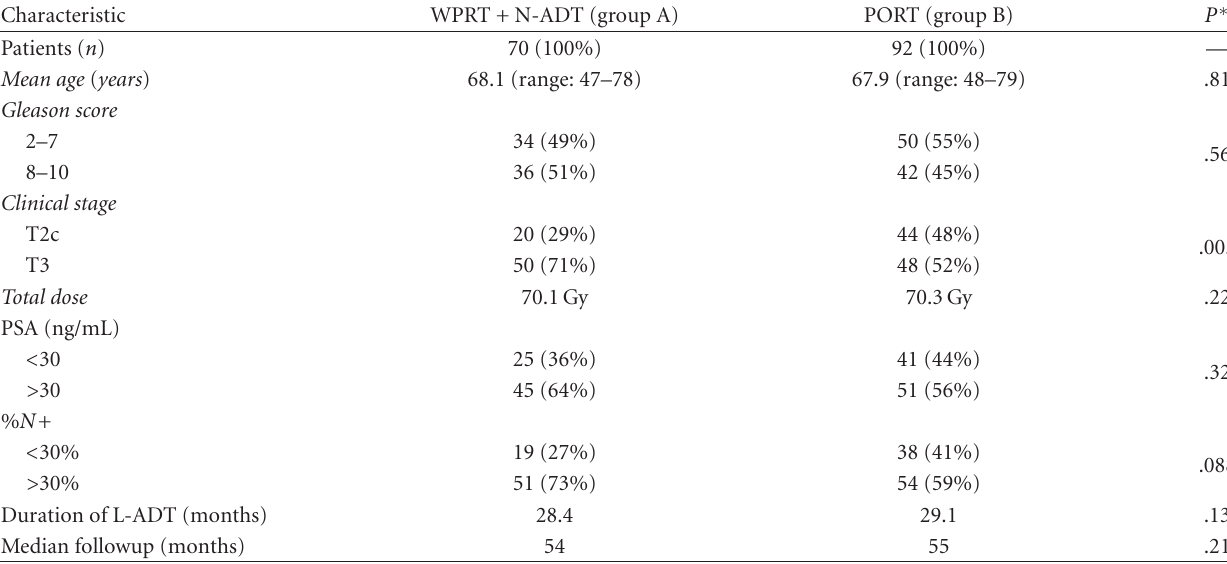
Table 1: Patient’s characteristics entered into prospective study for high-risk patients ( n = 162).